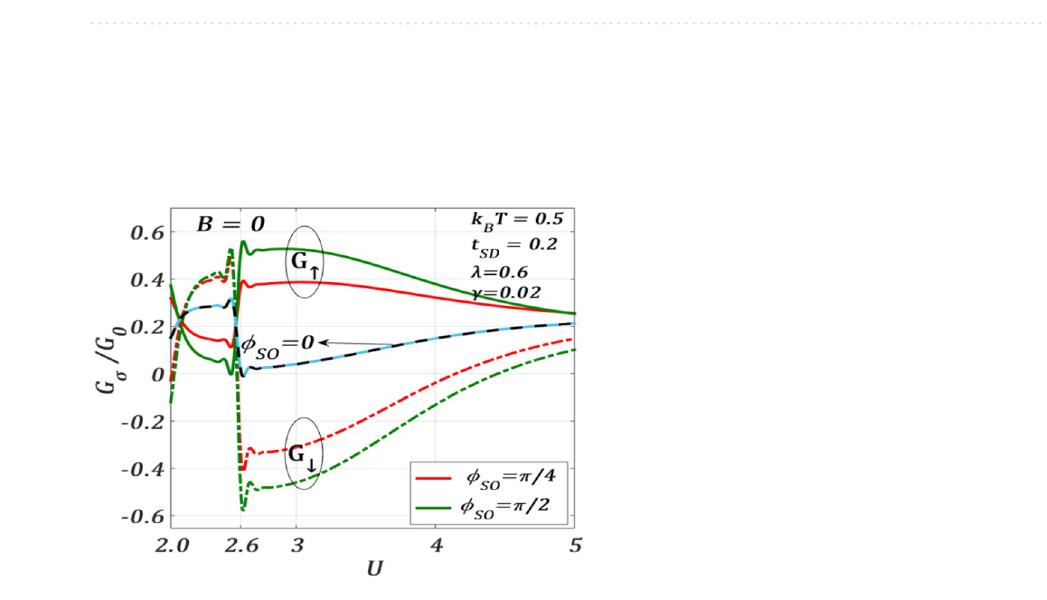
0.2, γ 0.02, (cid:31) 0.6, eV b = = =